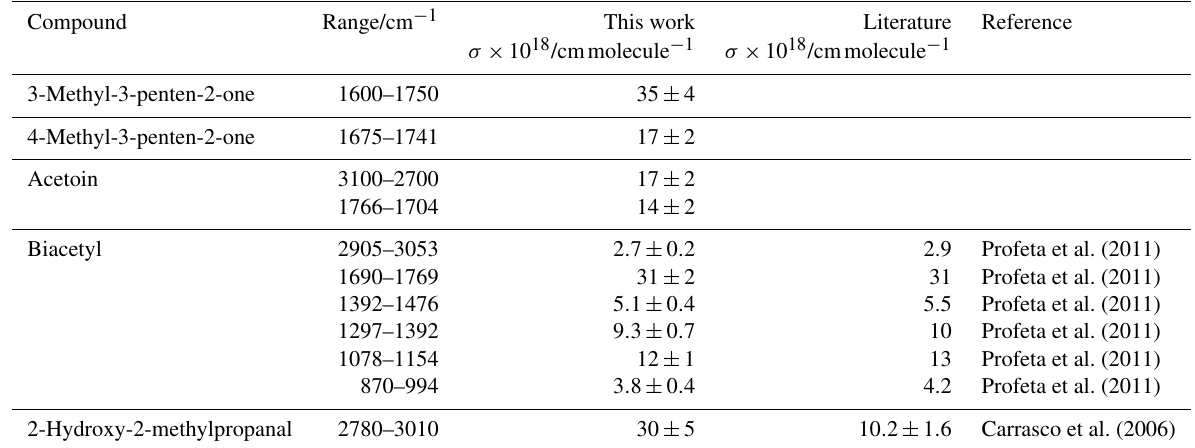
Table 3. Integrated absorption cross sections determined within this work (resolution: 1cm − 1 , apodization: Happ-Genzel, phase correction: Merck, zero-filling: 0) together with available literature